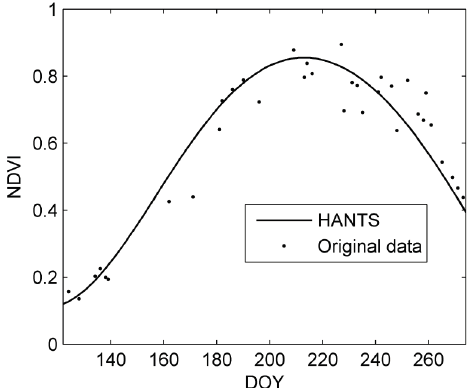
Figure 2. Observations ( dots ) and the HANTS reconstructed ( solid line ) NDVI time series for one pixel in oasis area of Heihe River Basin in